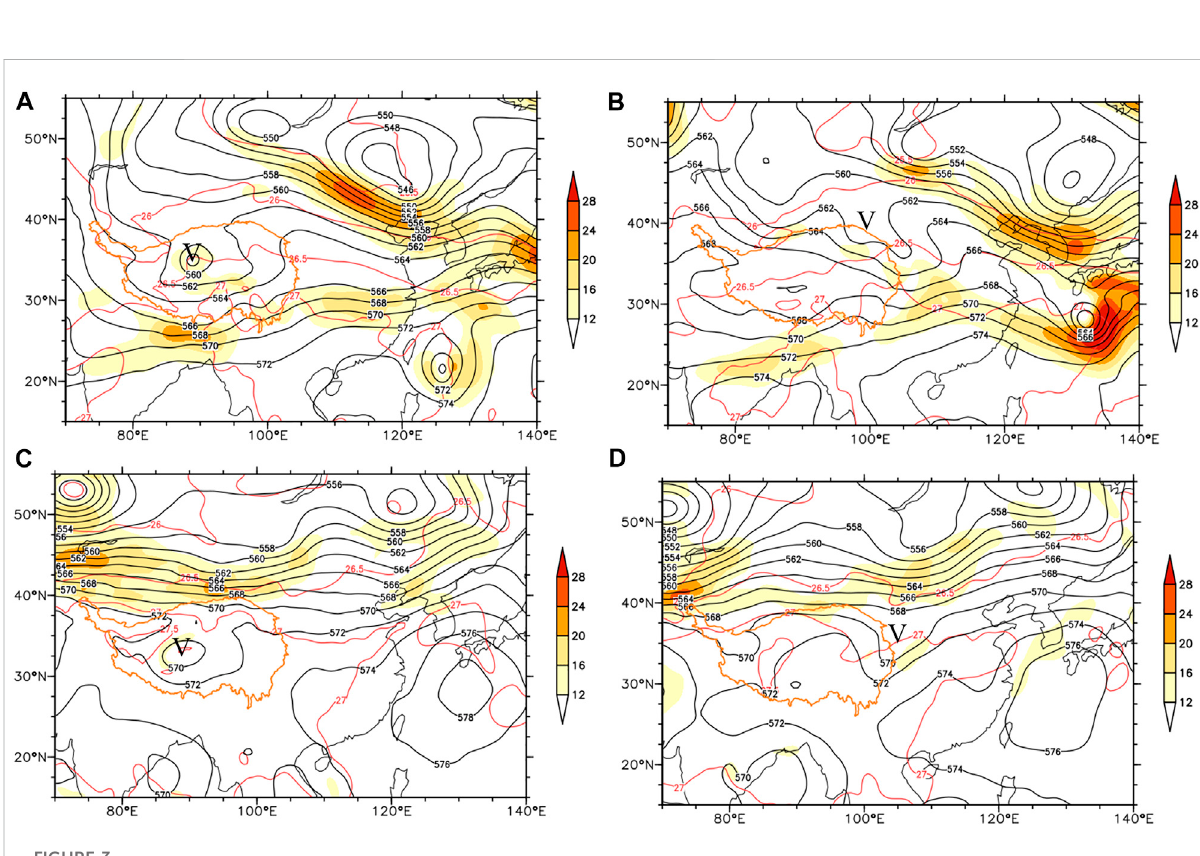
FIGURE 3 Geopotential height (black isolines; Unit: dagpm), temperature (red isolines; Unit: ° C) and strong wind area (shaded, wind speed ≥ 12 m/s) on 500 hPaatintermediatemomentsofplateaustage (A,C) andmoving-outplateaustage (B,D)(A) 00:004June2012, (B) 06:005June2012, (C) 12:00 20 July 2013, (D) 18:00 21 July 2013, V denotes the position of the vortex at the corresponding time) in Case 2012 (A,B) and Case 2013 (C,D) (The brown solid line is Tibetan plateau